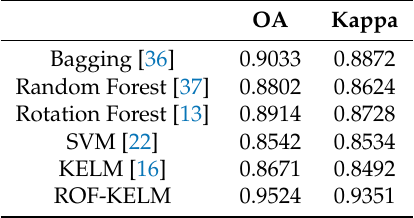
Table 4. The OA and Kappa comparison of ROSIS image data